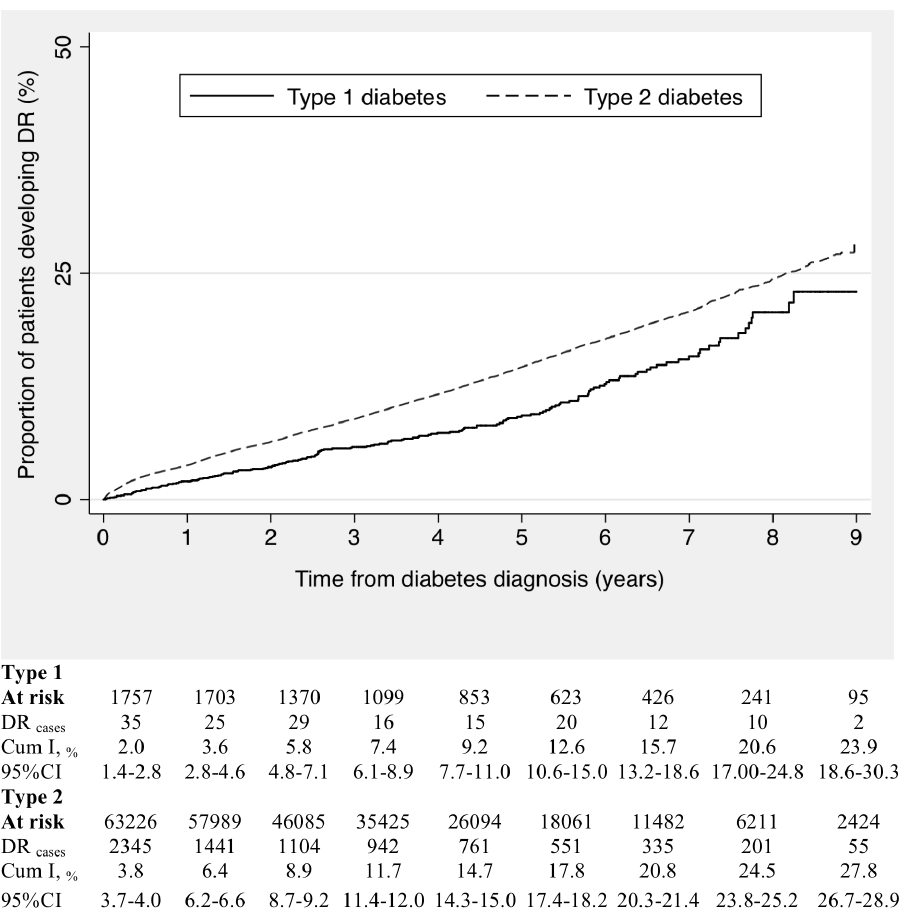
Figure 2. Kaplan-Meier curves and table of annual cumulative incidence of diabetic retinopathy from the date of first diabetes diagnosis recorded.